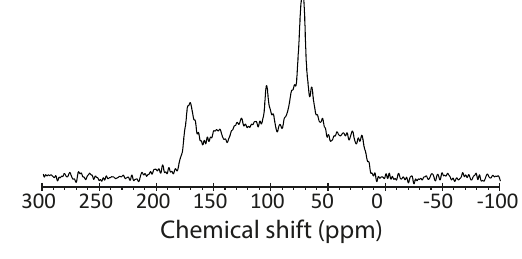
Figure 1. 13 C Cross-polarization magic angle spinning nuclear magnetic resonance spectrum ( 13 C CPMAS NMR) of the forest- floor